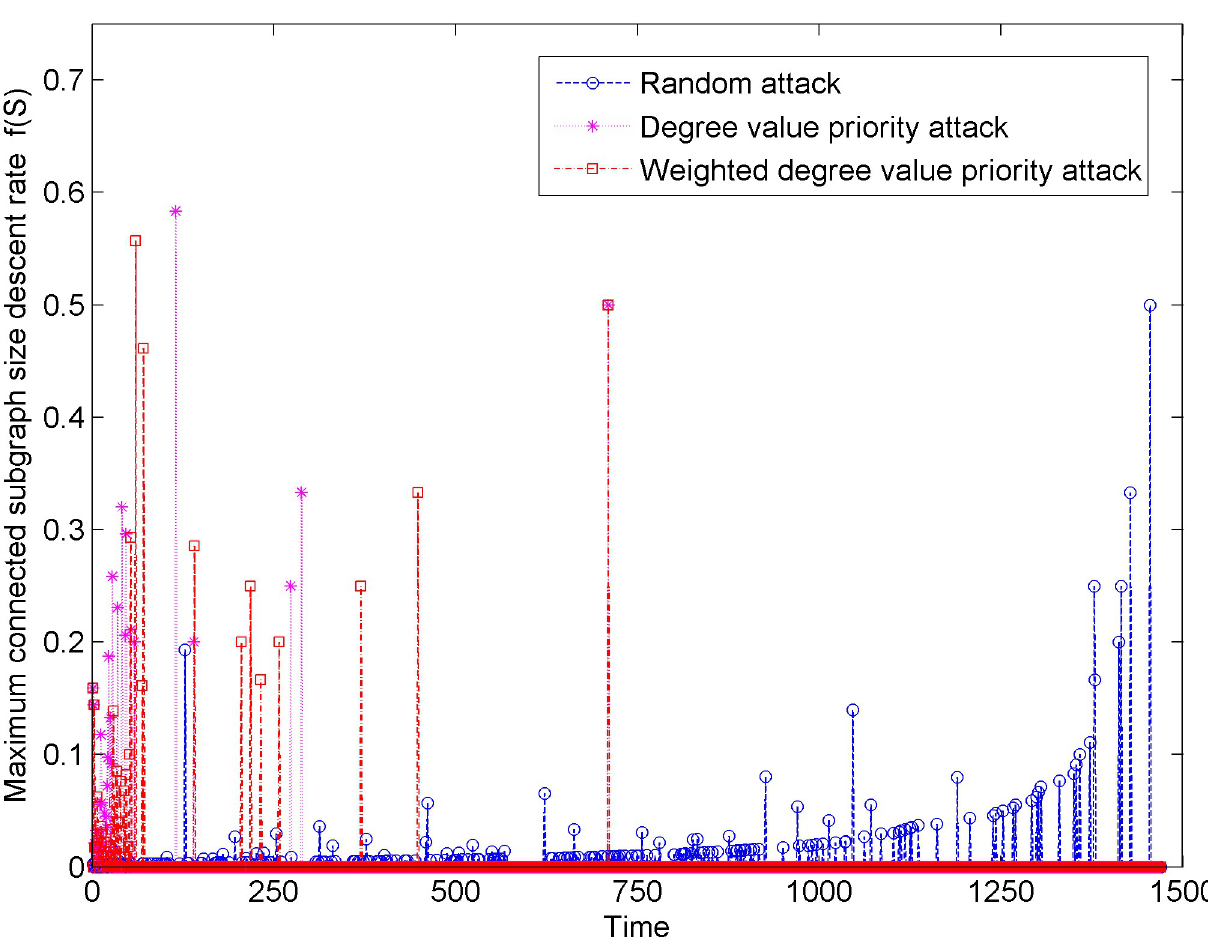
Fig 3. Change in maximum connected subgraph size descent rate under three types of